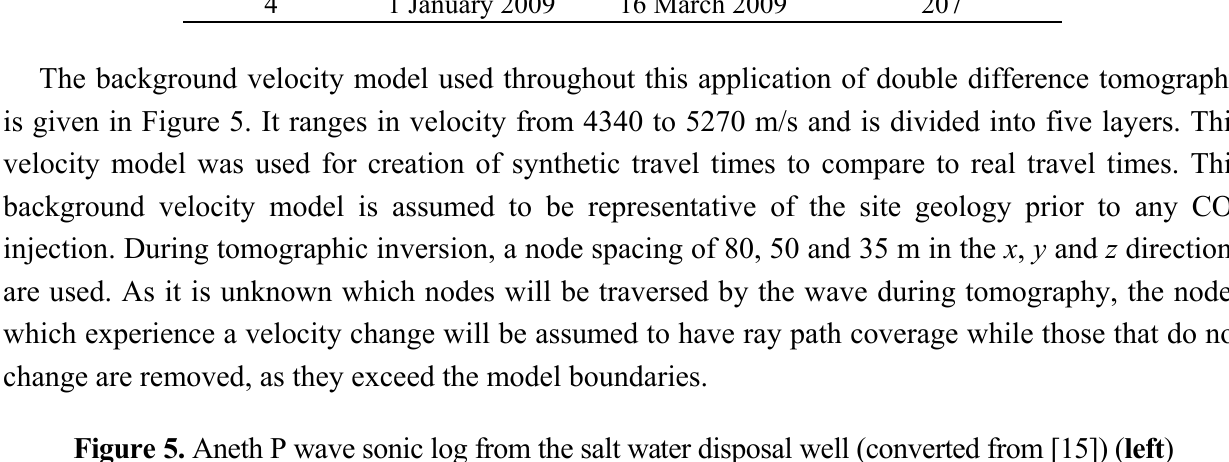
Figure 5. Aneth P wave sonic log from the salt water disposal well (converted from [15]) ( left ) and derived velocity model ( right